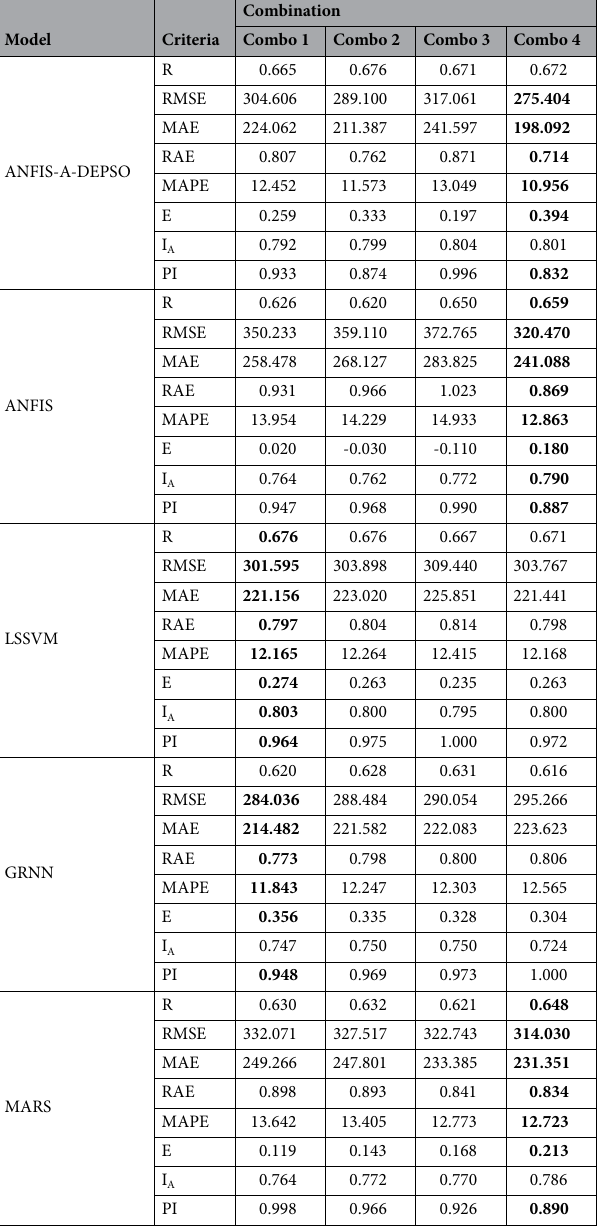
Table 5. Statistic metrics obtained by five ML models to forecast the EC parameter in testing stage. Significant values are in